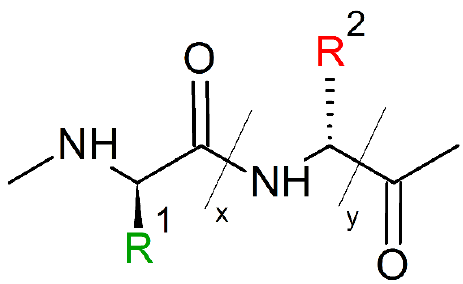
Figure 18. Schematic representation of cationic antimicrobial poly(α -amino acid)s (APAAs) mimic structures. R 1 (green) = -(CH 2 ) 4 NH 3+ Br - ; R 2 (red) = -CH 3 ; -CH(CH 3 ) 2 ; -CH(CH 3 )CH 2 CH 3 ; -CH 2 CH(CH 3 ) 2 ; -CH 2 C 6 H 5 .